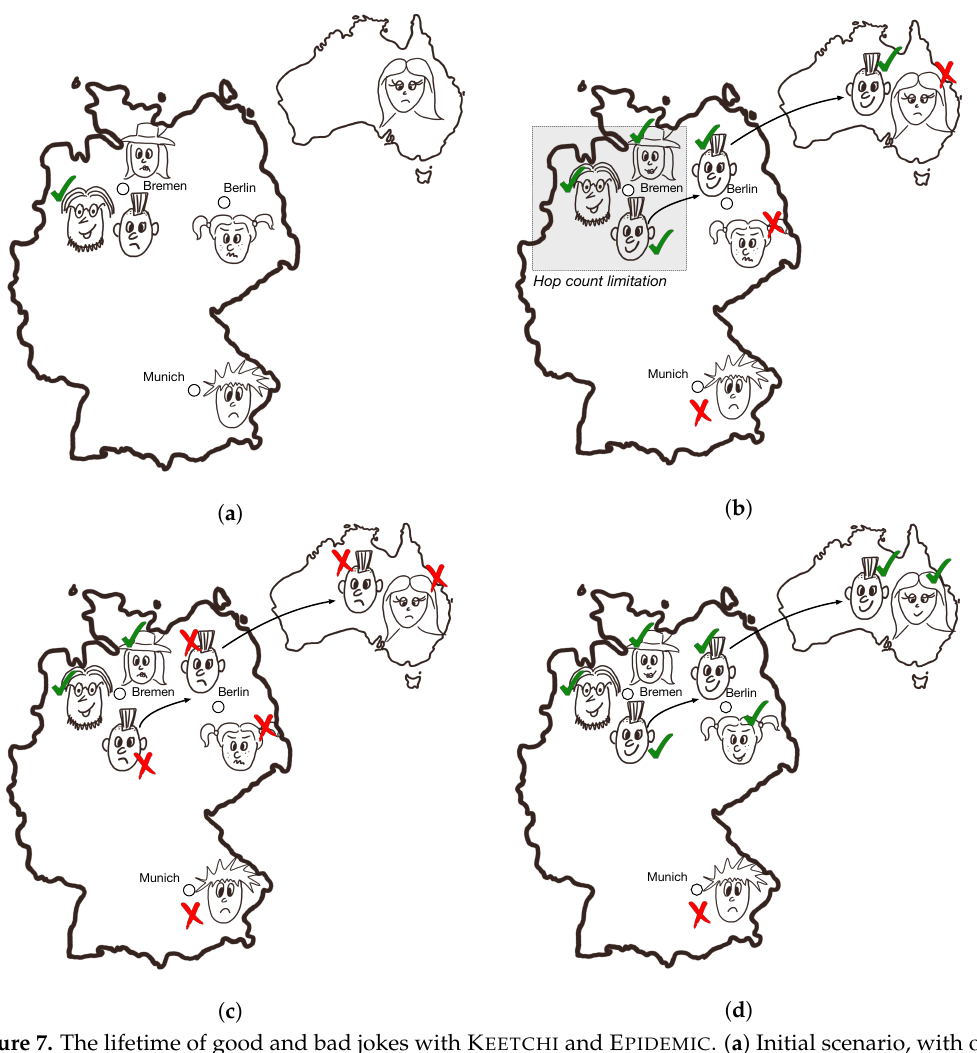
Figure 7. The lifetime of good and bad jokes with K EETCHI and E PIDEMIC . ( a ) Initial scenario, with one joke initiator (the happy person in Bremen). ( b ) The behaviour of E PIDEMIC , irrespective of whether the joke was good or bad. Only the people in Bremen received the joke. ( c ) The behaviour of K EETCHI , if the joke was bad. Maybe few people around the initiator will get it, but then it will be dropped. ( d ) The behaviour of K EETCHI , if the joke was good. Almost everybody will receive it, including far away people in Berlin and